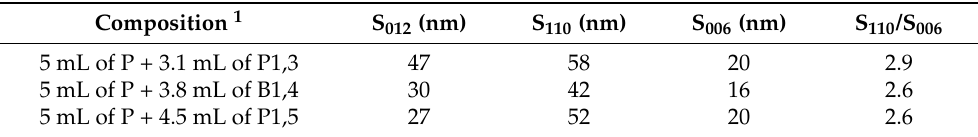
Table 3. Evolution of the nanocrystal sizes S 012 , S 110 , and S 006 (in nm) and anisotropic ratio for a fixed volume of precursor at 5mL and various co-solvents of increasing chain lengths. The molar ratio of glycol to ethanol was 0.5 in each